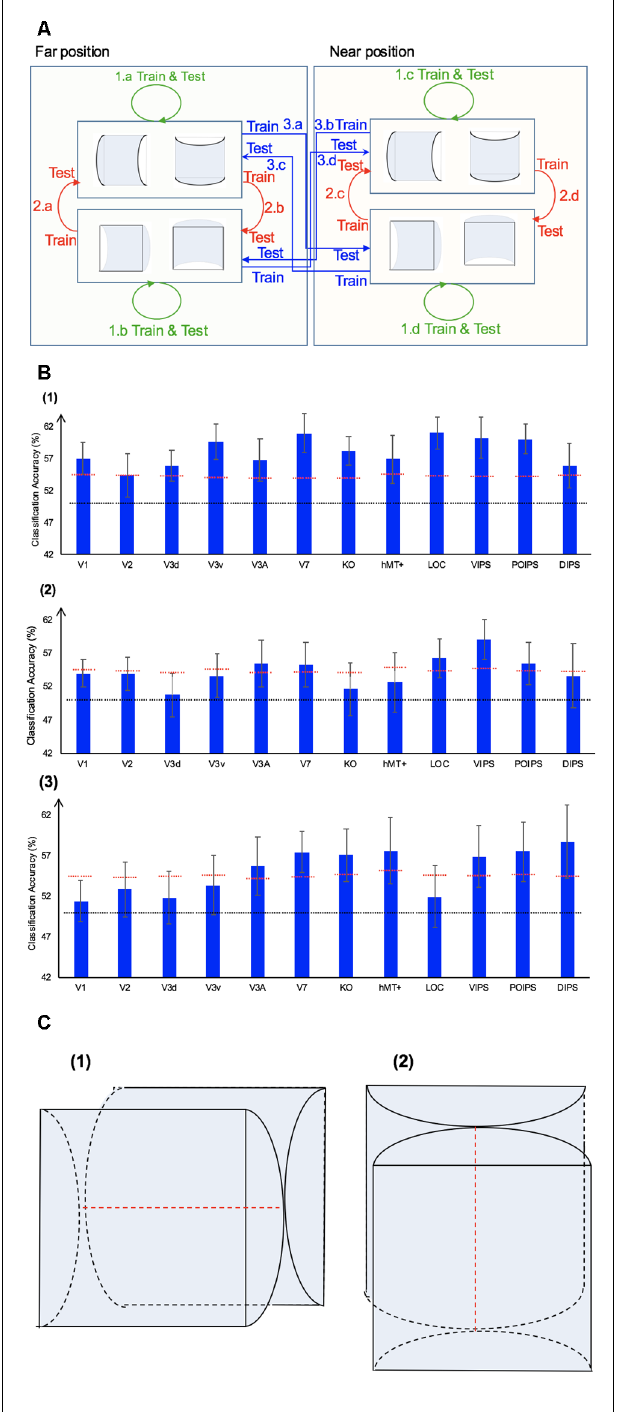
FIGURE 5 | The horizontal–vertical classification, results and local disparity for classification. (A) Illustration of the horizontal–vertical classification. 1.a, 1.b, 1.c, and 1.d indicate same-type stimuli horizontal–vertical surfaces classification. 2.a, 2.b, 2.c, and 2.d indicate transfer horizontal–vertical classification of surfaces with different signs of curvature at the same depth position. 3.a, 3.b, 3.c, and 3.d indicate transfer horizontal–vertical classification of surfaces with different signs of curvature at different